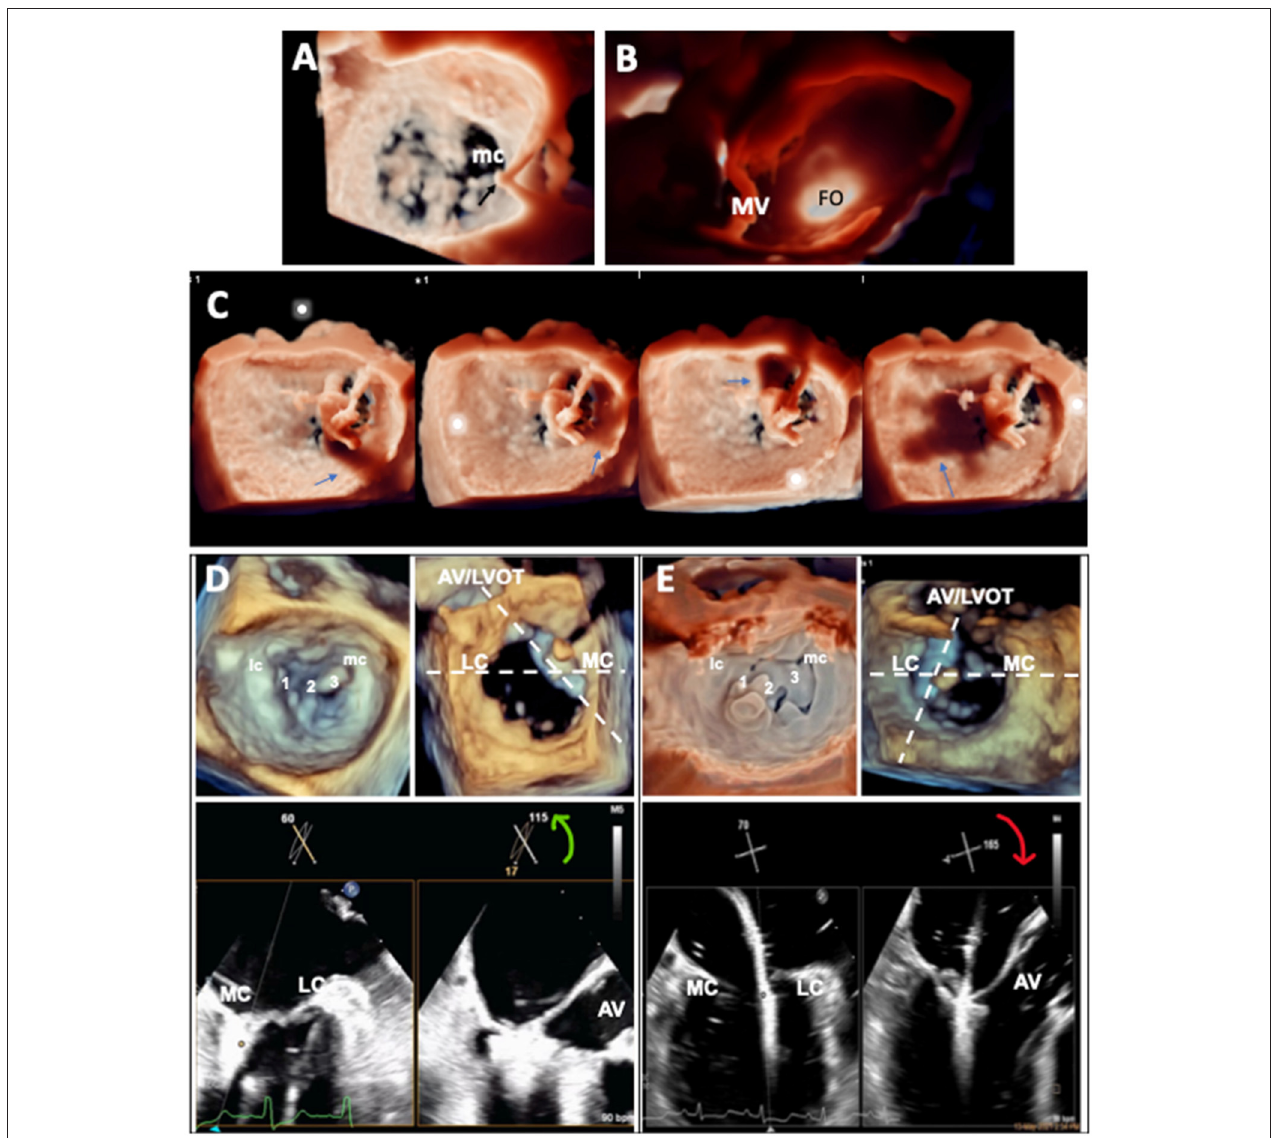
FIGURE 2 | Application of advanced TEE imaging in the guidance of mitral TEER procedure. (A) 3D en face view of the MV showing the position of tenting of the atrial septum by the transseptal puncture needle and its relationship with the medial commissure (mc) of the MV. (B) TI of the atrial septum showing the position of the fossa ovalis (FO) and its relationship with the MV. (C) TI with the virtual light source at different positions in the LA casting shadows (arrows) of the clip to enhance 3D perception of distance of the clip from adjacent structures during clip steering. (D,E) X-plane imaging (bicommissural and long-axis views) with simultaneous independent tilting and rotation facilitating leaflet grasping for medial (D) and lateral (E) commissural